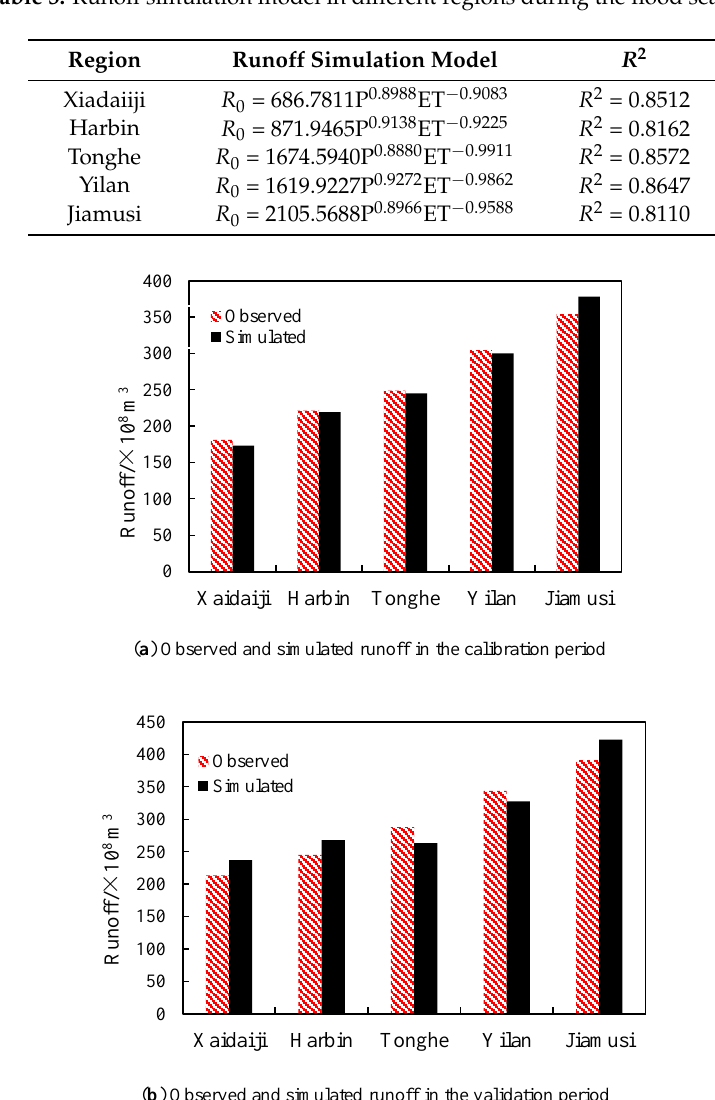
Table 3. Runoff simulation model in different regions during the flood season.